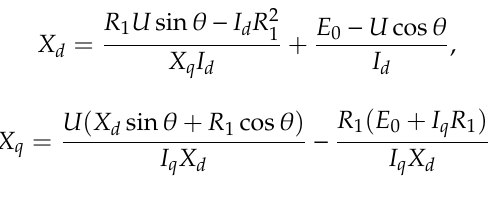
Table 4. No-load, back-induced EMF ( E 0 ) with different N S values.